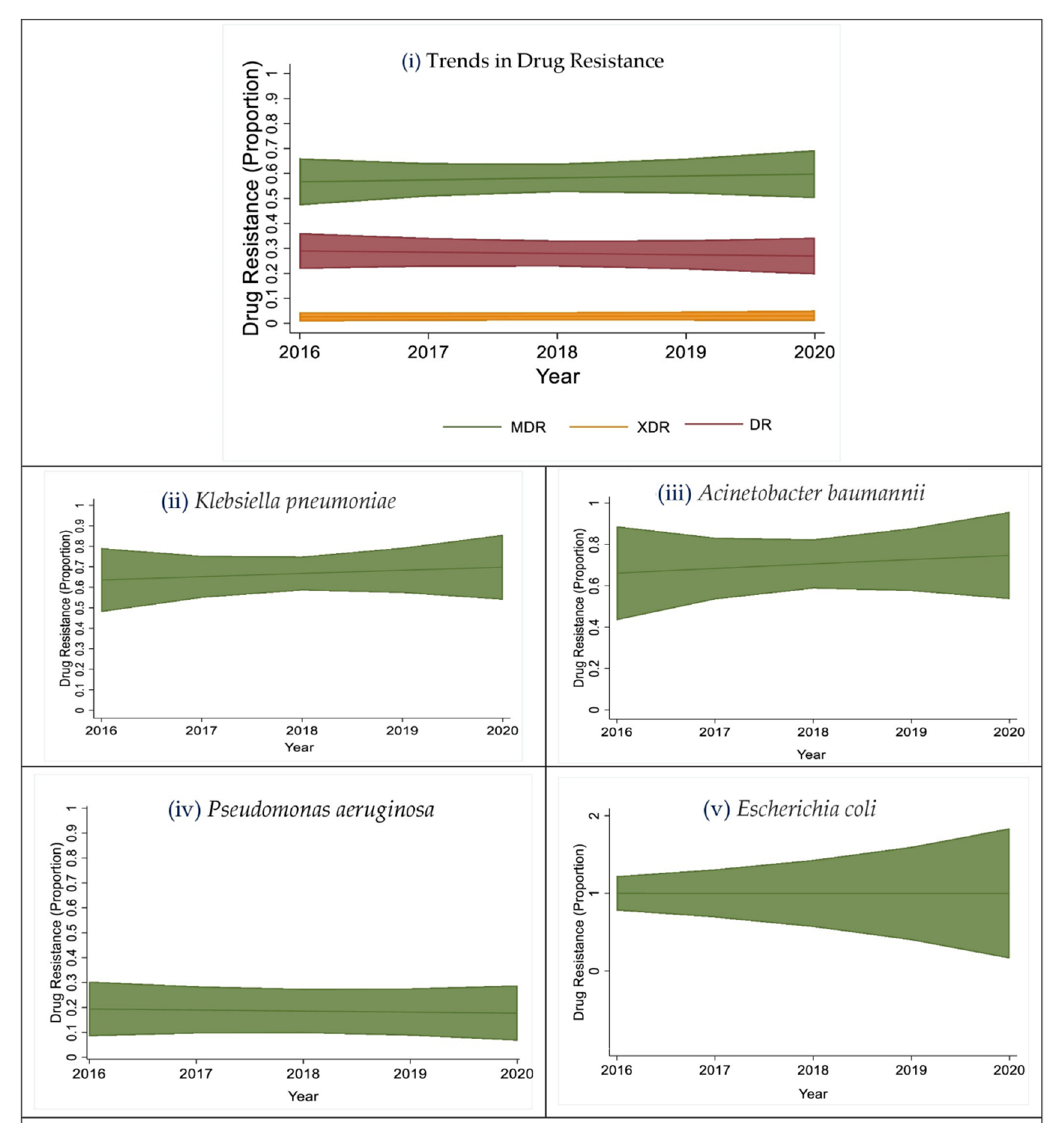
Figure 5. ( i ) shows the trends in single-drug resistance, multi-drug resistance, and extreme drug- resistance in the top five bacterial organisms isolated, from the year 2016 to 2020; ( ii ) shows the trends in the multi-drug drug resistance in Klebsiella pneumoniae isolates and the constant MDR organisms were isolated every year, from 2016 to 2020; ( iii ), shows the trends in the multi-drug drug resistance in Acinetobacter baumannii isolates, from the year 2016 to 2020; ( iv ) shows the trends in the multi-drug drug resistance in Pseudomonas aeruginosa isolates, from the year 2016 to 2020; and ( v ) shows the trends in the multi-drug drug resistance in Escherichia coli isolates, from the year 2016 to 2019; (Note: Proportion 0.1 = 10%, 1 = 100%; No Escherichia coli were isolated in 2020, which was due to the COVID-19 pandemic which led to fewer patient admissions and in turn fewer culture positive